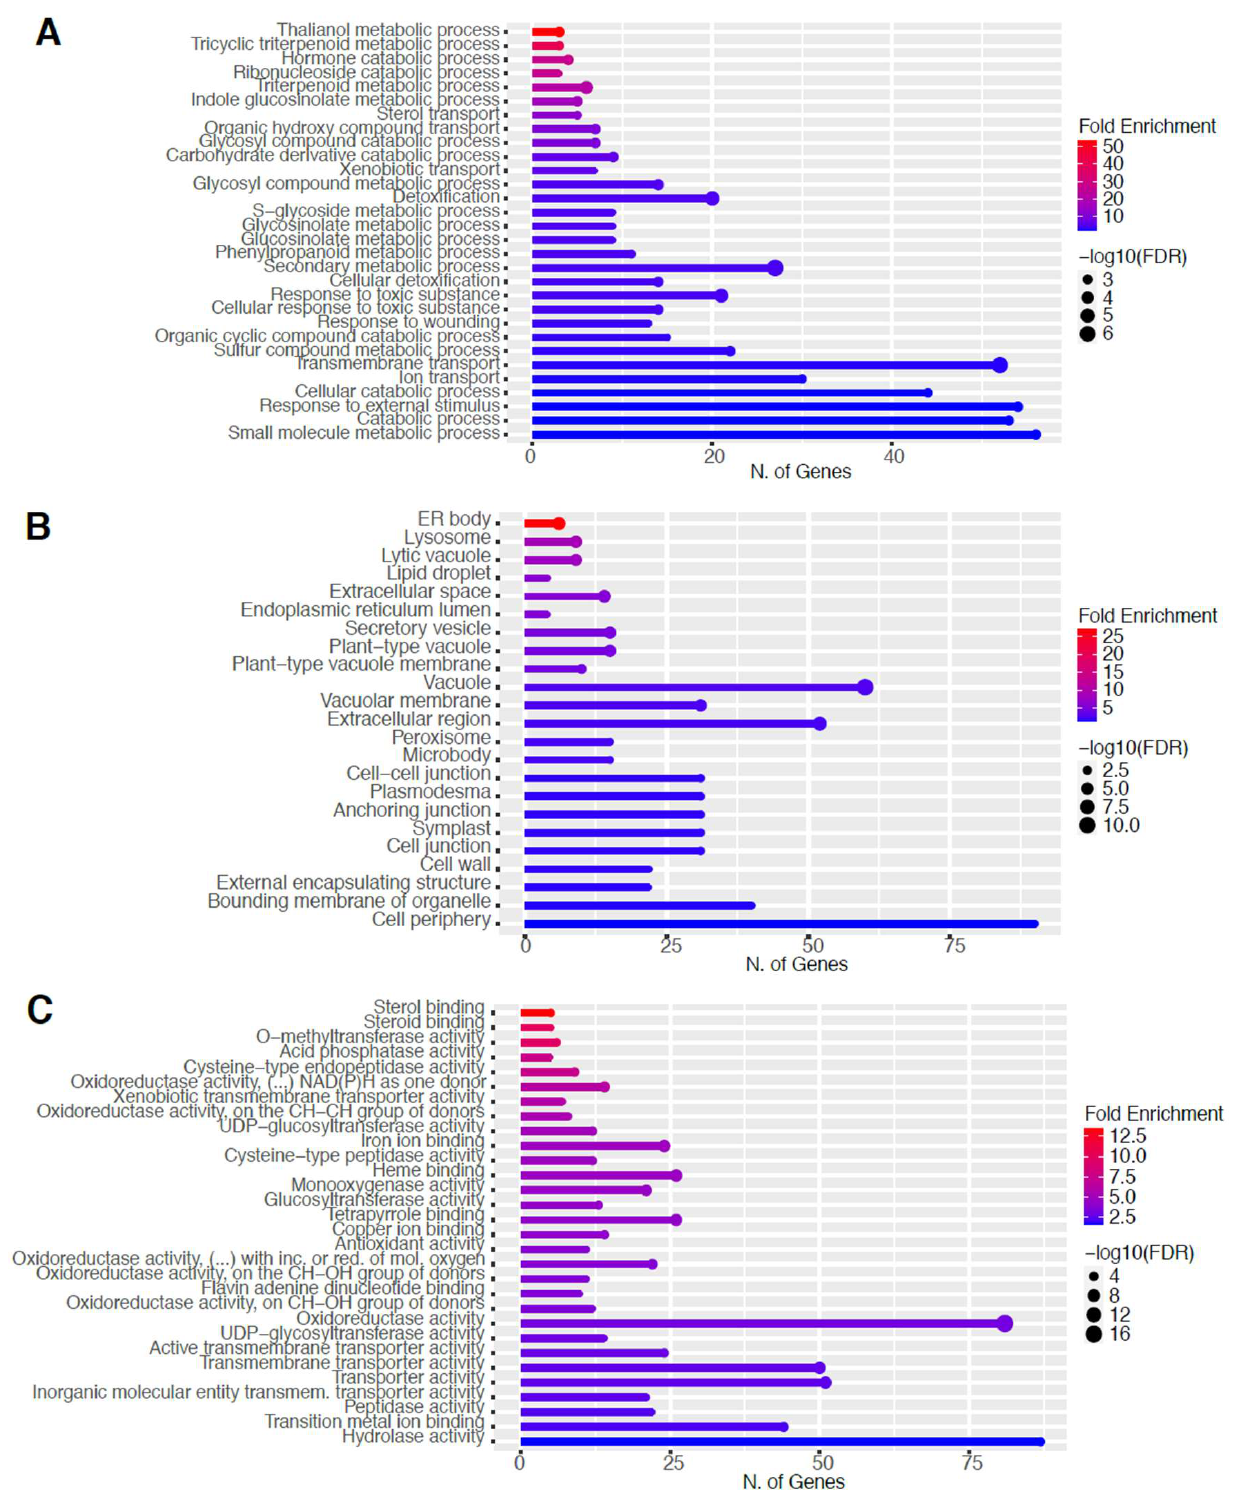
Figure 7. Gene enrichment analysis for upregulated genes after 80 s plasma treatment. Lollipop diagrams provide information about GO fold enrichment, significance (FDR in log10), and number of genes in each pathway. From top to bottom, GO categories are in the following order: ( A )